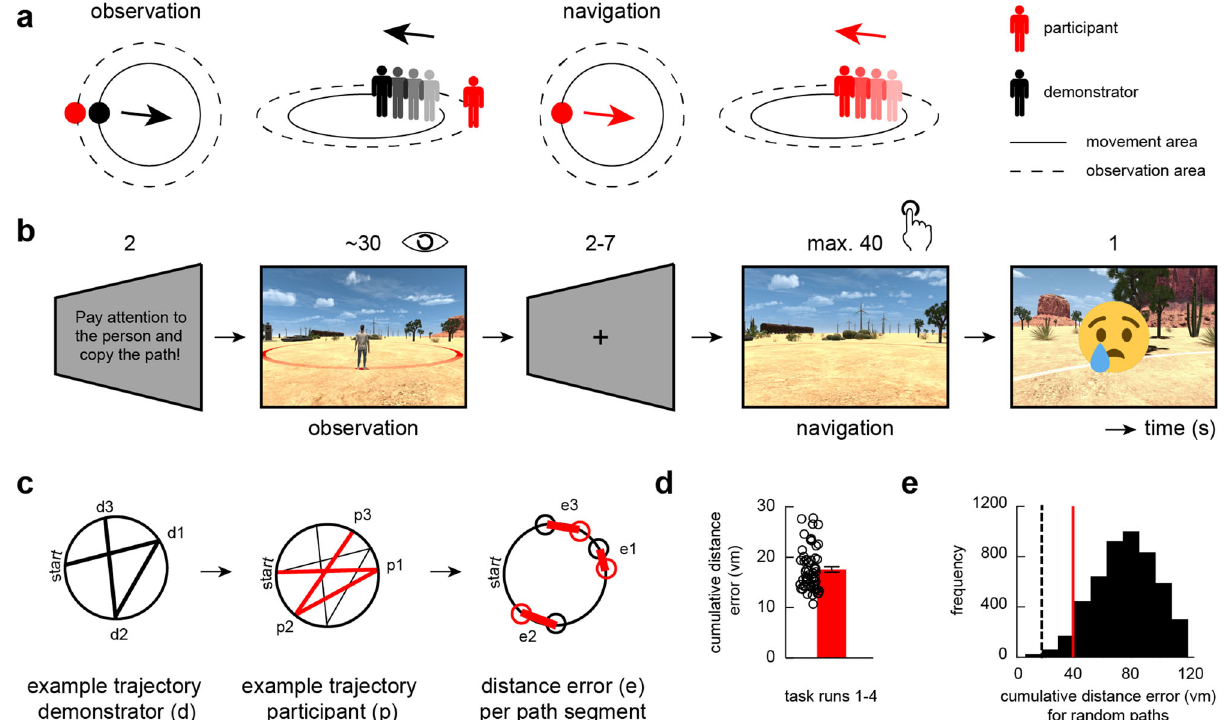
Fig. 1 | Modi fi ed navigation task. a The task projected participants into a fi rst- person perspectivewithin a virtualreality (VR)environment whilethey wereasked to observe and subsequently re-trace the paths of a demonstrator. The movement areawasmarkedwitharedcircleonthesandydesertplaneandwassurroundedby an observation area (solid and dashed circles in bird ’ s eye and street views, respectively). During observation (left panel), participants were placed directly behind the demonstrator ’ s starting point, were not able to move, and viewed the demonstrator walking through the circular arena (movement trajectory schemati- callyindicated).Duringnavigation(rightpanel),thedemonstratordisappearedand the participant was projected onto the same starting position to re-trace the pre- viously observed path. b Timeline of one example trial during the modi fi ed navi- gation task (s, seconds). A performance threshold of 20 virtual meters (vm) determinedthefeedbackthatparticipantsreceived oneachtrial(i.e.,happyemoji,